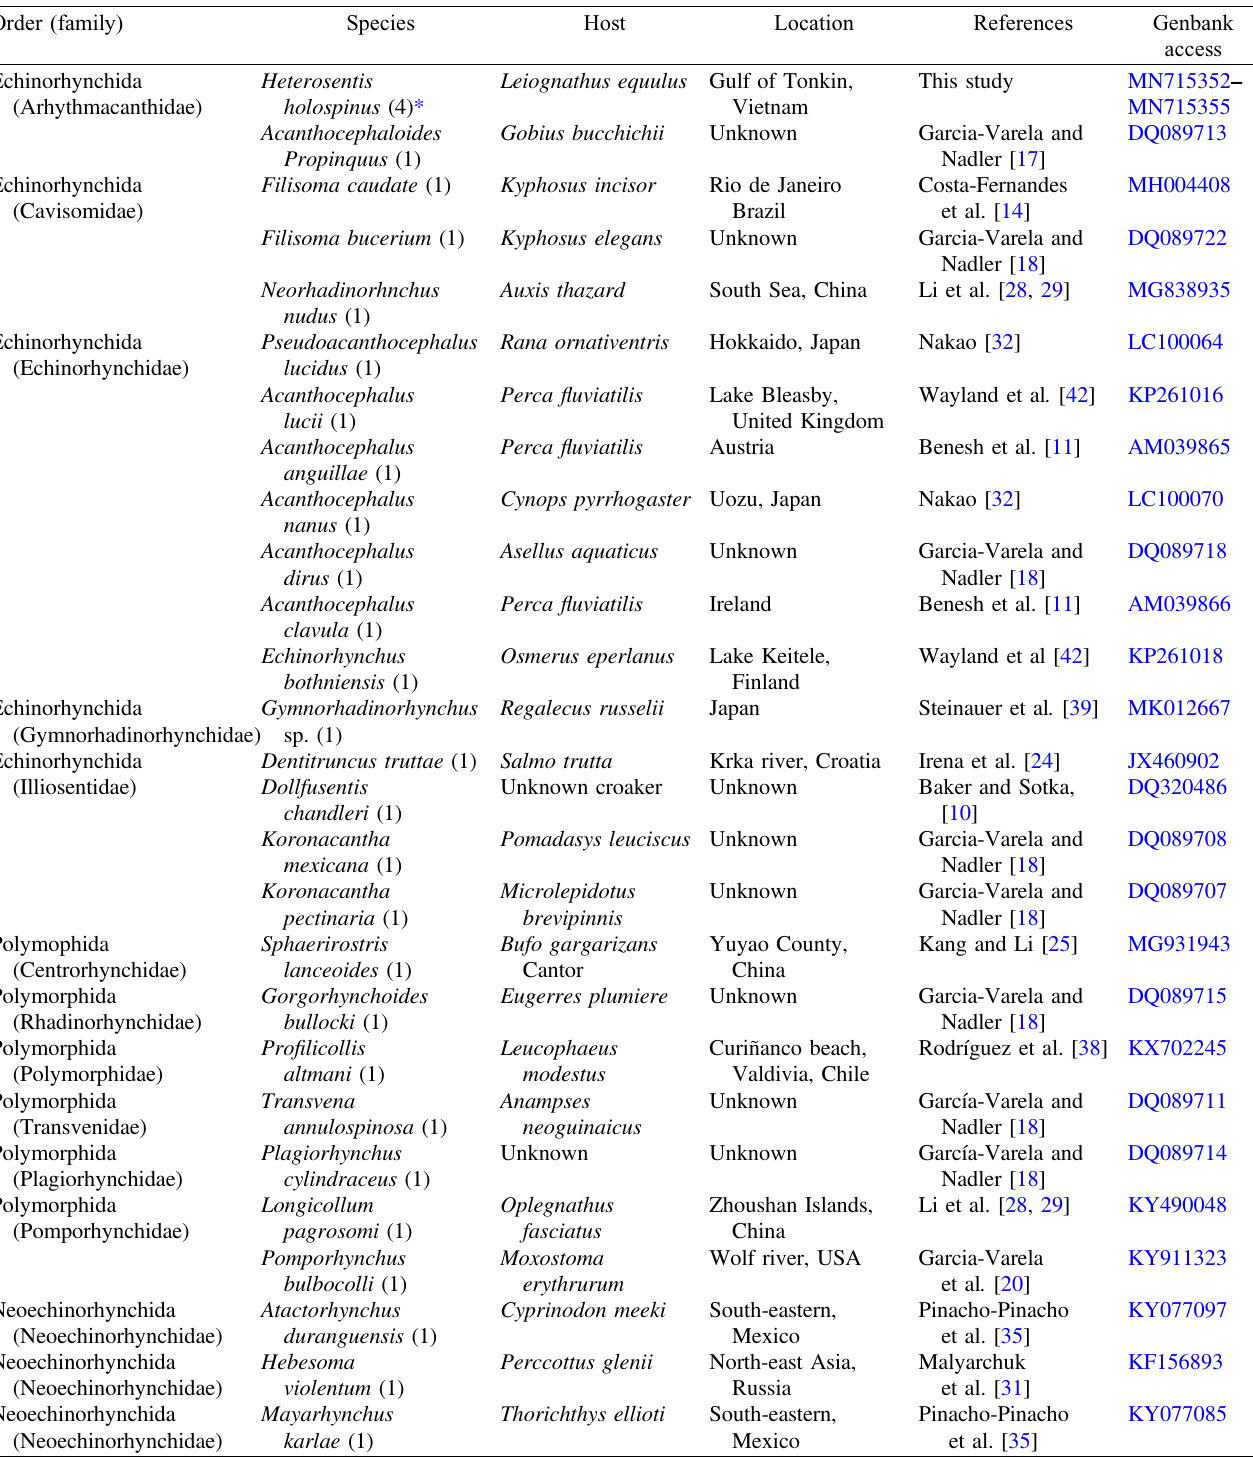
Table 1. Species of acanthocephalans, their hosts, origins, and GenBank accession numbers used for phylogenetic analysis based on the cox 1